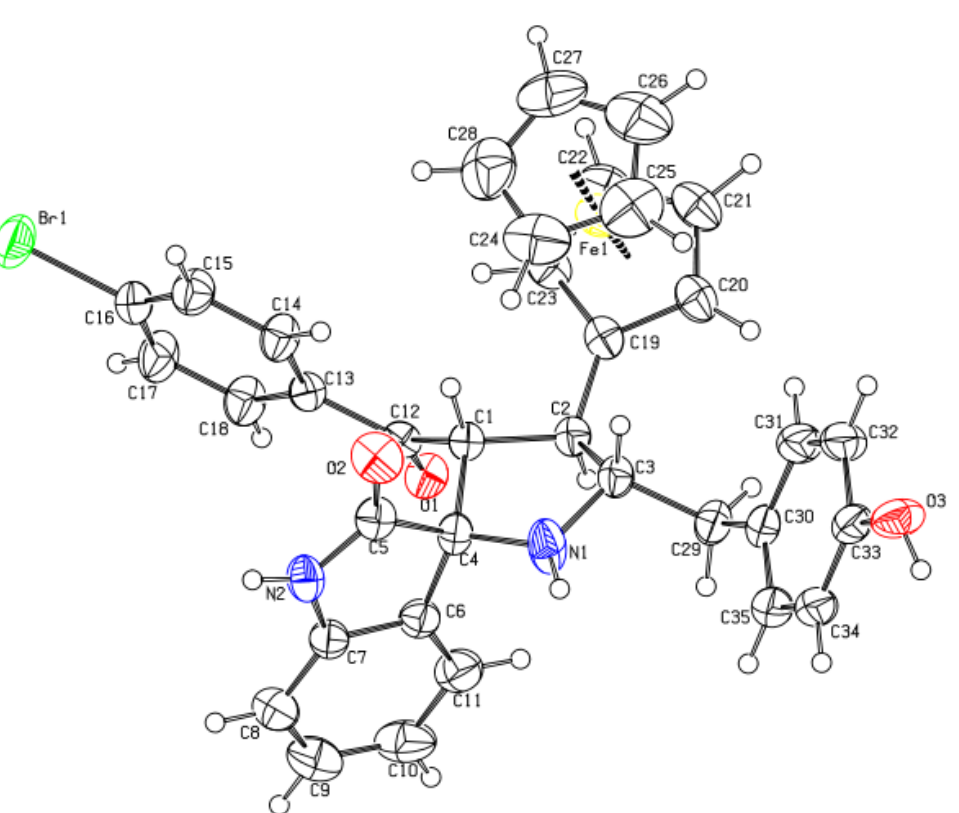
Figure 2. A view along the ac -plane showing different hydrogen bonding interactions. Table 5. Structural unique crystal data and refinement parameters for 3a. Designed Code